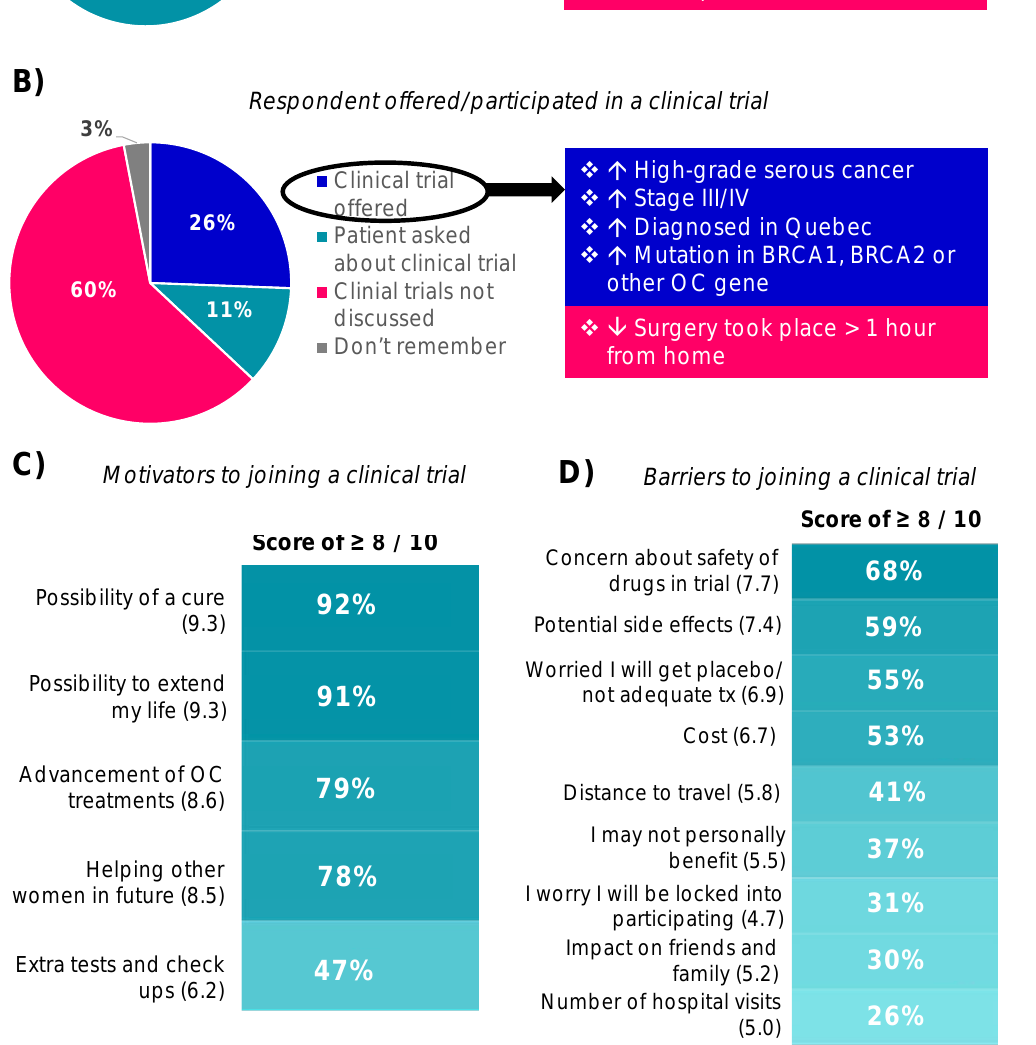
Figure 4. An overview of genetic testing and clinical trials. Panel ( A ) shows the breakdown of reported genetic testing before or after diagnosis. Statistically significant predictors of being offered genetic testing after diagnosis are shown at right (“ ↑ ” indicates variables that increased likelihood of being offered testing, while “ ↓ ” indicates variables that decreased likelihood of being offered testing; p -values in Table S10). Panel ( B ) shows the breakdown of whether a clinical trial was offered by the respondent’s healthcare team, with statistically significant predictors shown at right ( p -values in Table S12). The ranking of factors that would be considered important motivators ( C ) or barriers ( D ) to joining a clinical trial in future are shown; the proportion of respondents that gave each factor a score of 8 or more (out of 10) is indicated. Abbreviations: GT—genetic testing; OC—ovarian cancer .